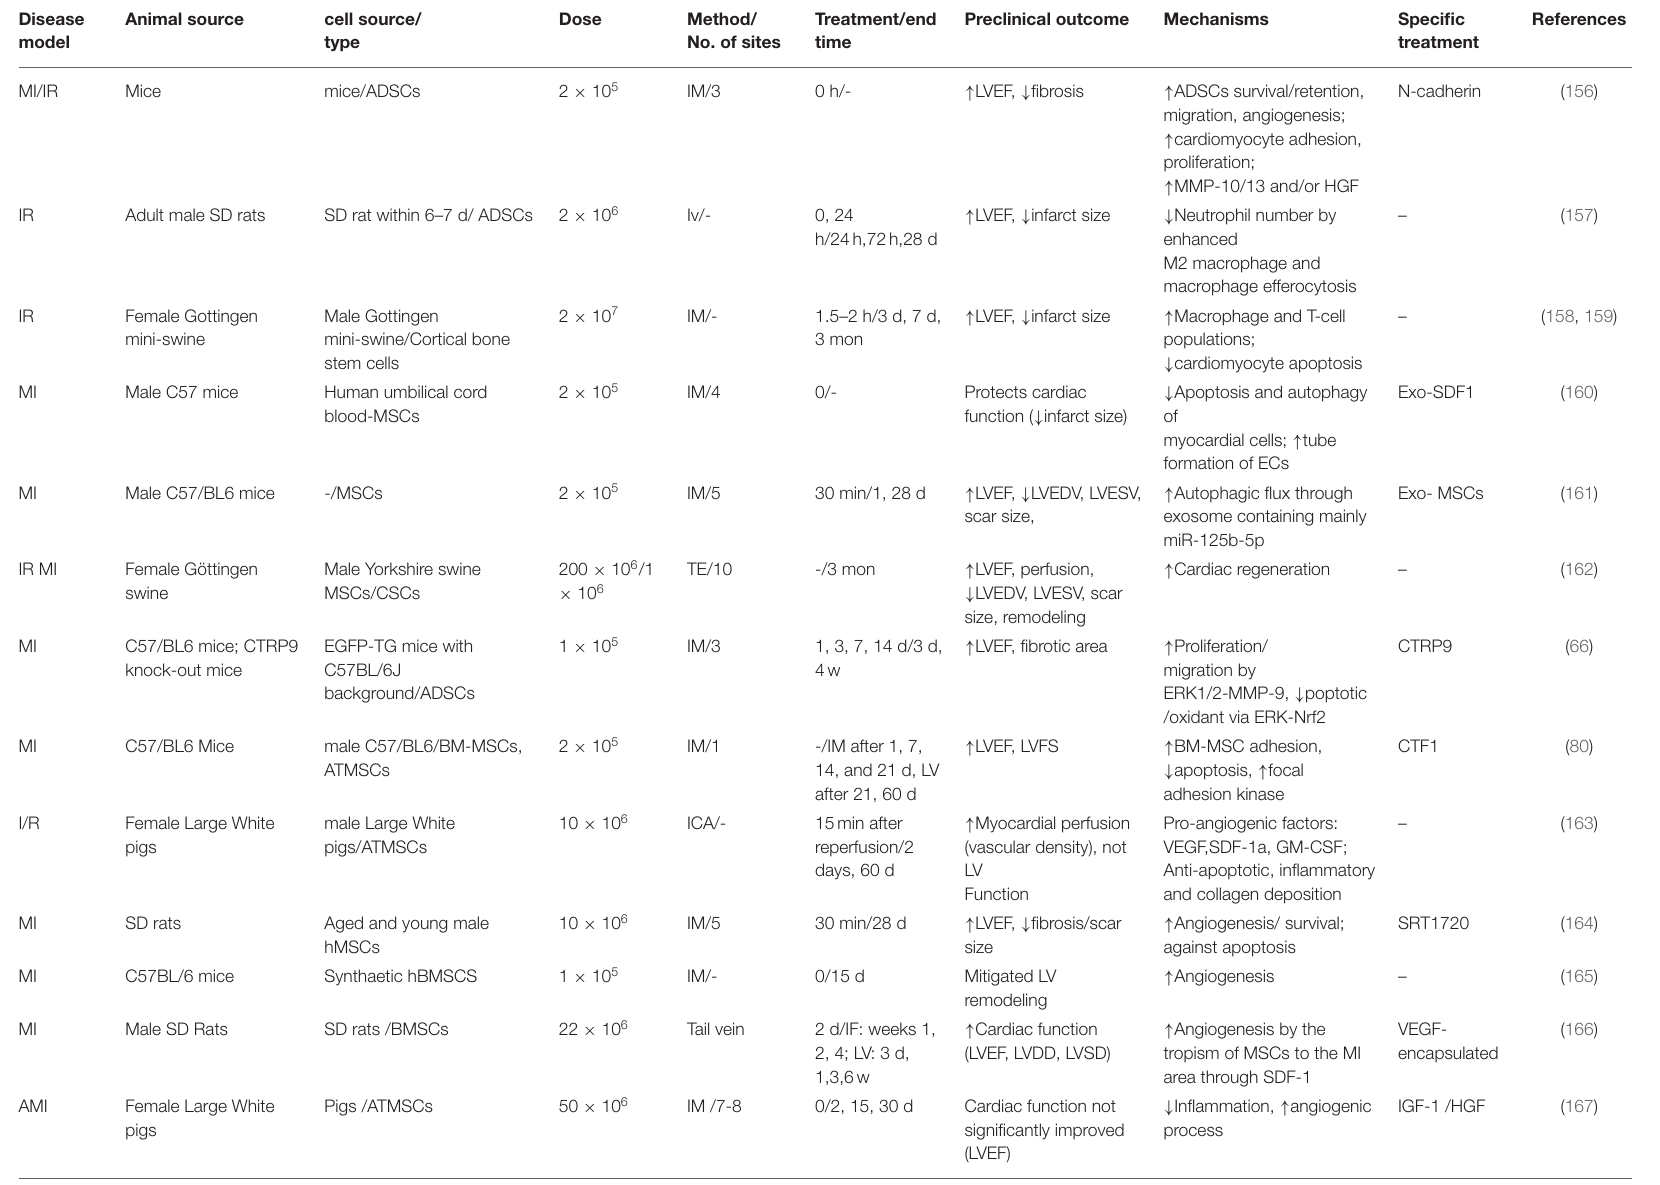
TABLE 3 | Representative animal studies performed using MSCs in ischemic models. Disease